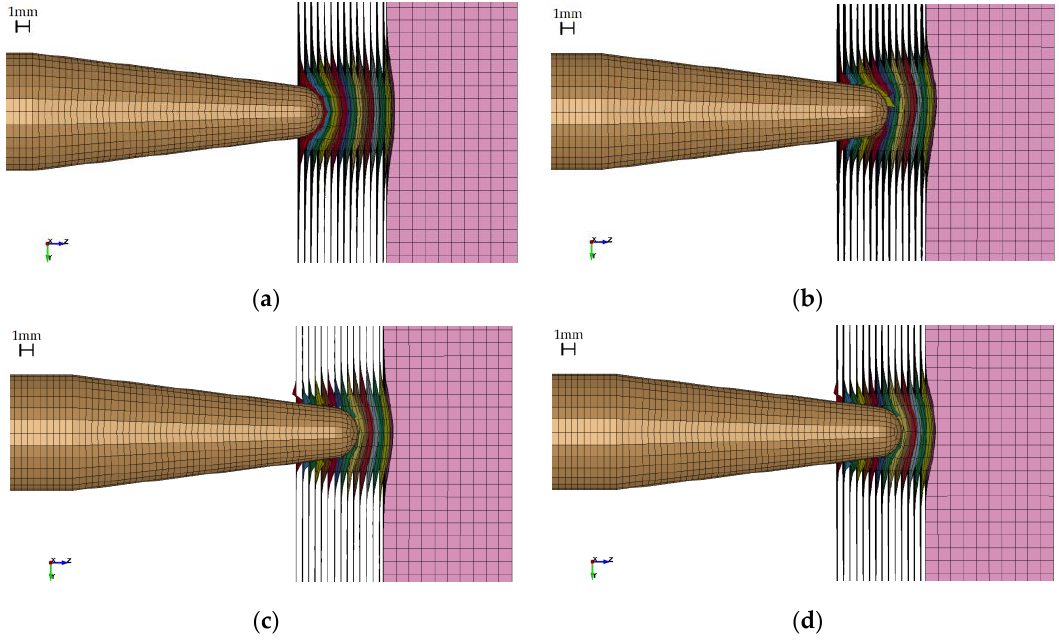
Figure A6. Damage caused by the ogival striker at different instances of the simulation: ( a ) time = 0.1 ms, ( b ) time = 0.2 ms, ( c ) time = 0.3 ms, ( d ) time = 0.35 ms.